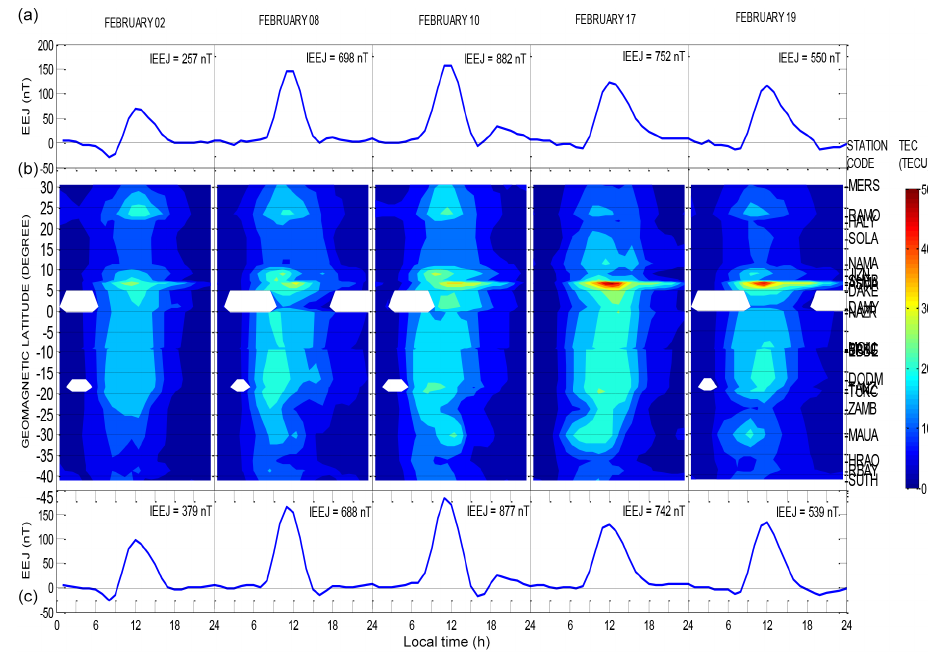
Figure 3. The TEC magnitudes of the quietest days, equatorial electrojet (EEJ) strength, and integrated EEJ strength in February.